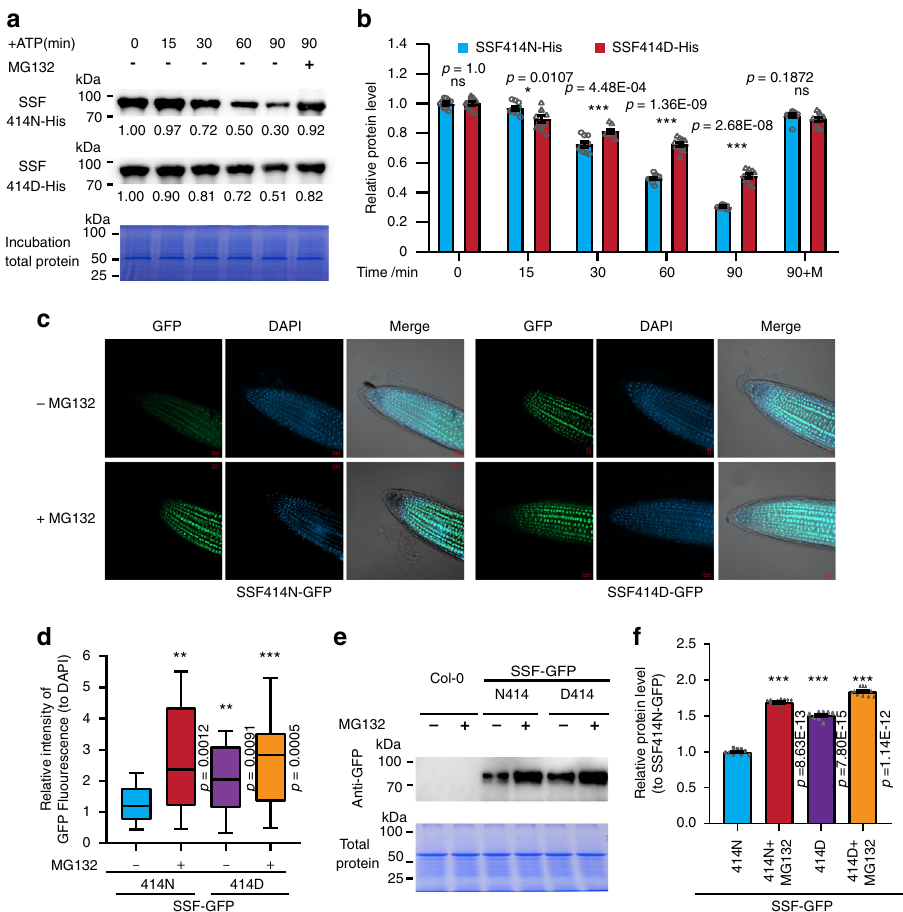
Fig. 6 The natural polymorphism SSF-N414D affects protein stability through the ubiquitination pathway. a , b The degradation of SSF414D was slower than that of SSF414N in the cell-free protein degradation assay. Recombinant puri fi ed His-SSF414N/414D was incubated in equal amounts of total proteins extracted from 14-day-old wild-type Col-0 seedlings in the presence of ATP. His-SSF414N/414D was detected with an anti-His antibody. Representative images are shown in ( a ), and relative protein levels are shown in ( b ). In ( b ), data are presented as mean ± SEM, and n = 10 independent replicates. c , d Stability of SSF414N/414D-GFP in vivo. Fourteen-day-old SSF414N-GFP and SSF414D-GFP transgenic seedlings were treated with 50 μ M MG132. In ( c , d ), SSF-GFP- and DAPI-stained nuclear signals in roots of 18 independent lines were collected by confocal microscopy and quantitatively analyzed under the same set of fl uorescence intensities and at the same scale. From each line, more than 10 seedlings were assayed. Representative pictures are shown in ( c ), and the relative GFP signal level is normalized to DAPI in ( d ). In ( d ), box plot: lower vertical bar = sample minimum, lower box = lower quartile, middle line = median, upper box = upper quartile, upper vertical bar = sample maximum, single points = outliers. e , f Detection of SSF-GFP in vivo from Col-0, SSF414N-GFP, and SSF414D-GFP plants. Total protein was extracted from whole seedlings of 14-day-old Col-0, SSF414N-GFP, and SSF414D-GFP plants, incubated with GFP-trap to enrich GFP-fused protein, and analyzed by immunoblotting using an anti-GFP antibody. Total protein was used as the input loading control. In ( f ), data are presented as mean ± SEM, and n = 10 independent replicates. These experiments were repeated at least three times, and consistent results were obtained. In ( b , d , f ), asterisks indicate signi fi cant differences (* p < 0.05; ** p < 0.01; *** p < 0.001, ns, not signi fi cant; two-tailed unpaired t test). Source data are provided as a Source data fi